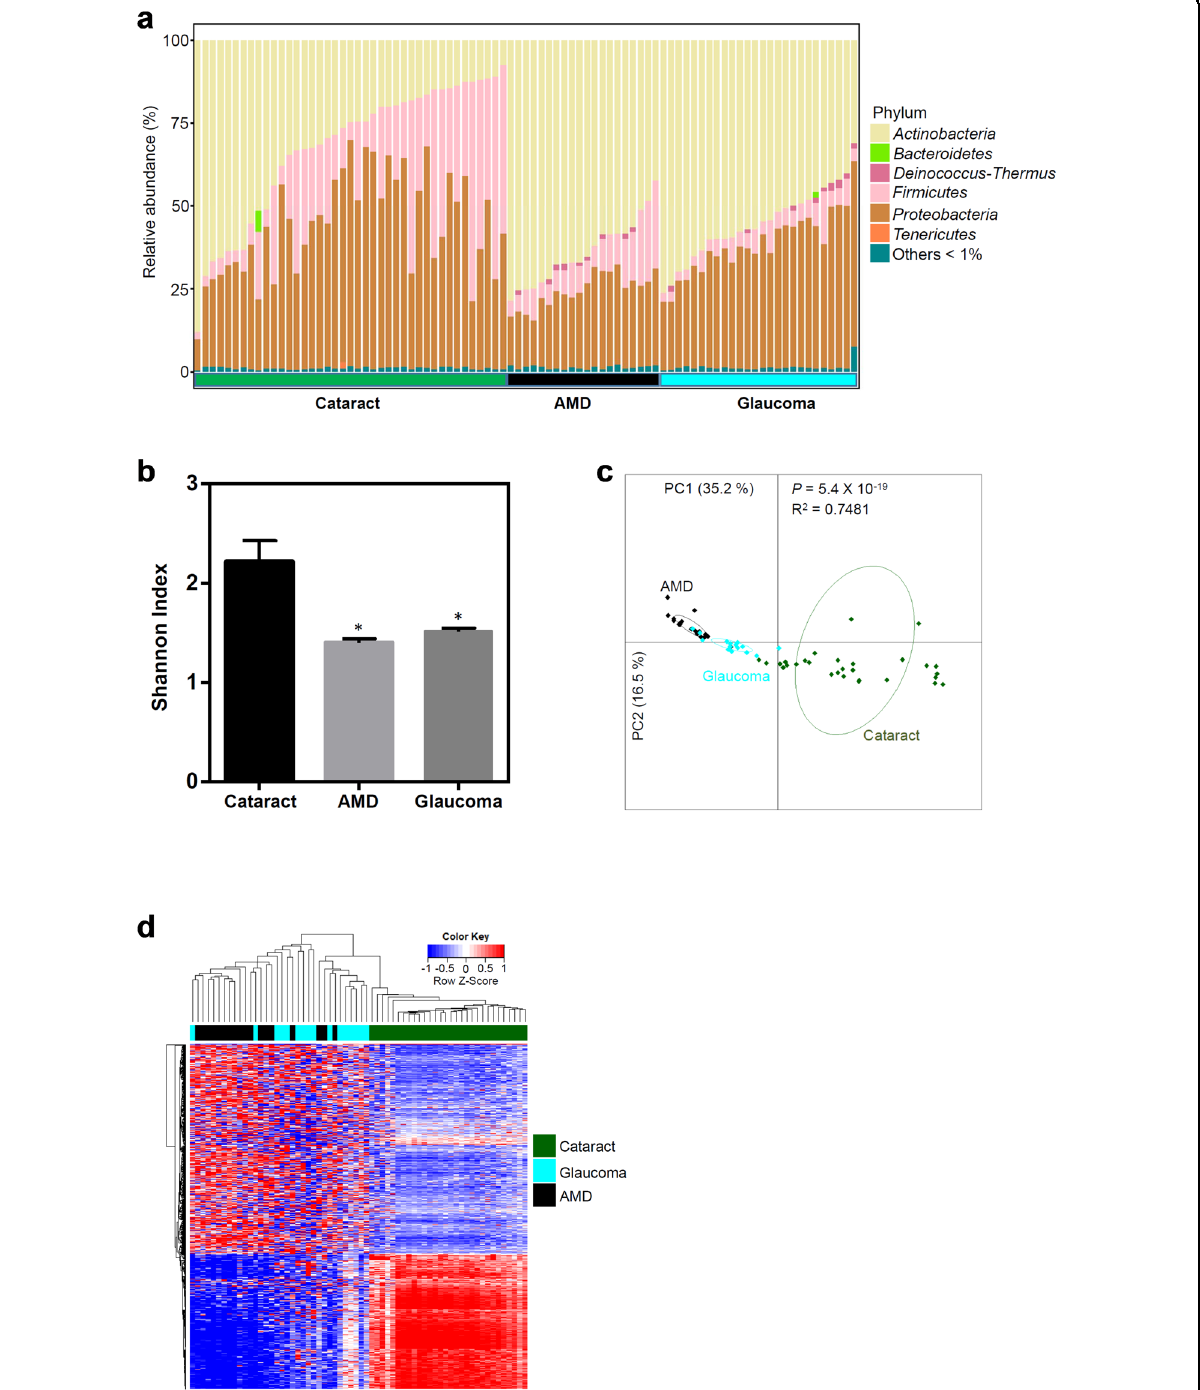
Fig. 4 The microbiota in AH from patients with cataract, AMD, and glaucoma. a Relative abundance of the six major phyla of bacteria in the intraocular metagenomes in patients with cataract ( N = 41), AMD ( N = 20), or glaucoma ( N = 26). b The alpha diversity (measured by Shannon index) of the intraocular metagenomes in patients with cataract, AMD, and glaucoma. The error bar represents the mean of all Shannon index within the disease group ± SEM. The statistical difference was measured between patients with cataract and each of other disease groups, respectively. Mann- Whitney U test signi fi cance levels are denoted by asterisks (* P < 0.05). c PCoA of the similarity of the intraocular metagenomes in patients with cataract ( N = 30), AMD ( N = 18), and glaucoma ( N = 16). The Bray Curtis distance was used and P value was calculated using PERMANOVA test. d Hierarchical clustering analysis of the functional genes in the intraocular metagenomes in patients with cataract ( N = 30), AMD ( N = 18), and glaucoma ( N =